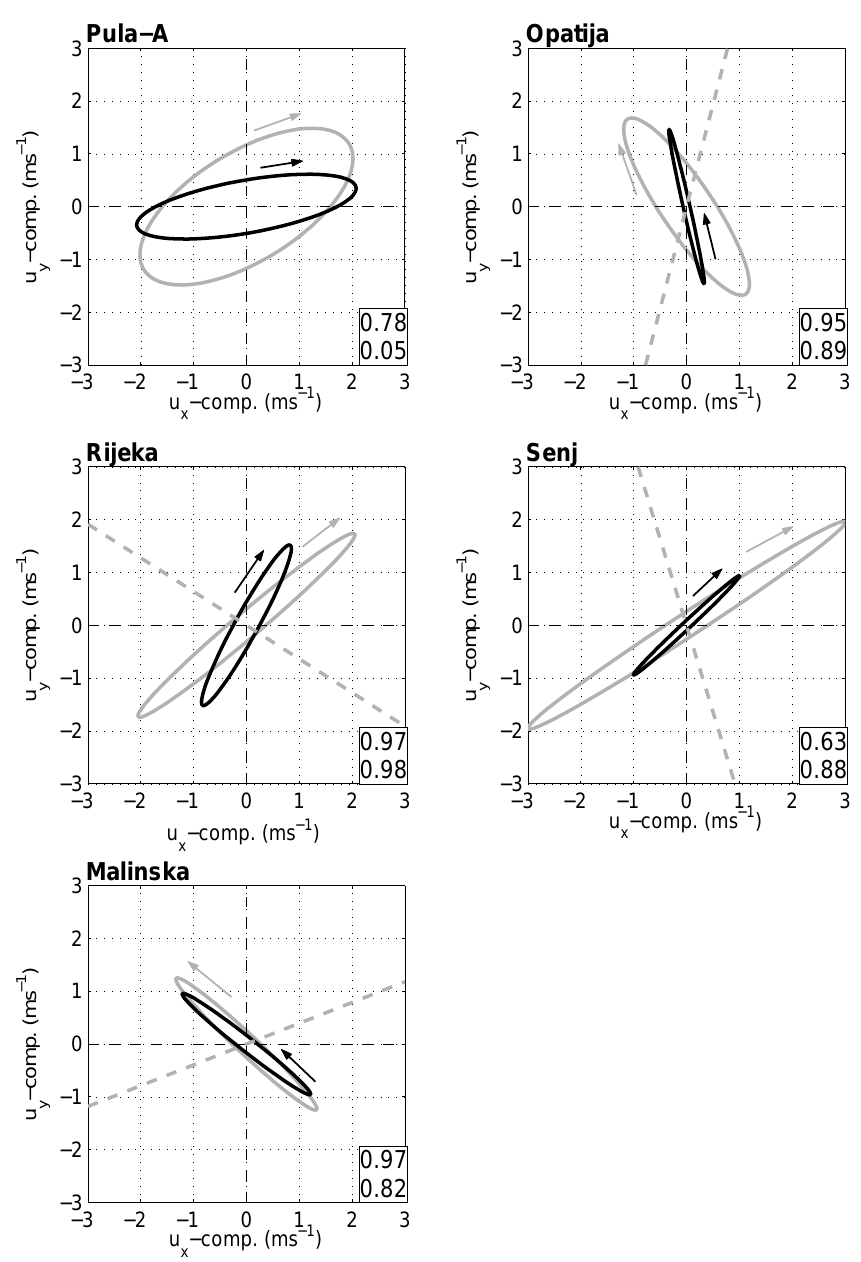
Fig. 8. The averaged ellipses for four different multi-day intervals for the selected stations and corresponding grid points in the inner domain: measurements (black) and model (grey). The stability parameters are depicted in the lower right corner: measurements (above) and model (below). The arrow indicates the sense of rotation of wind vectors and the dashed line the orientation of the local coastline. The exception is Pula-airport, which is situated at the tip of Istria peninsula with the nearest coastline being 10km